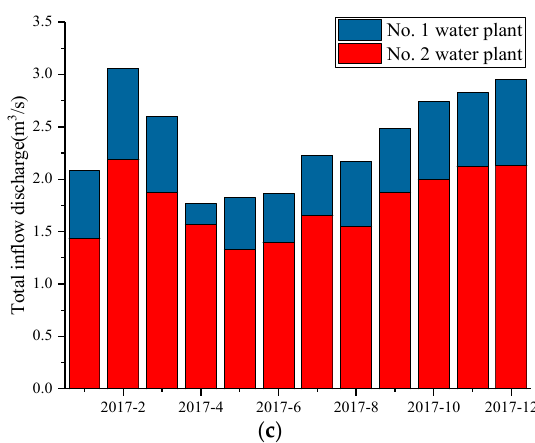
Figure 4. ( a ) Daily temperature, rainfall and wind speed of Xuanwu Lake in 2017; ( b ) Daily wind direction of Xuanwu Lake in 2017; ( c ) Monthly total inflow discharge of Xuanwu Lake in 2017. Water quality: The water quality (TP, TN) of inflow water is shown in Figure 5a, and the boundary of the outlet water quality (TP, TN) is shown in Figure 5b. Water quality data was supplied by the Nanjing Environmental Protection Bureau.